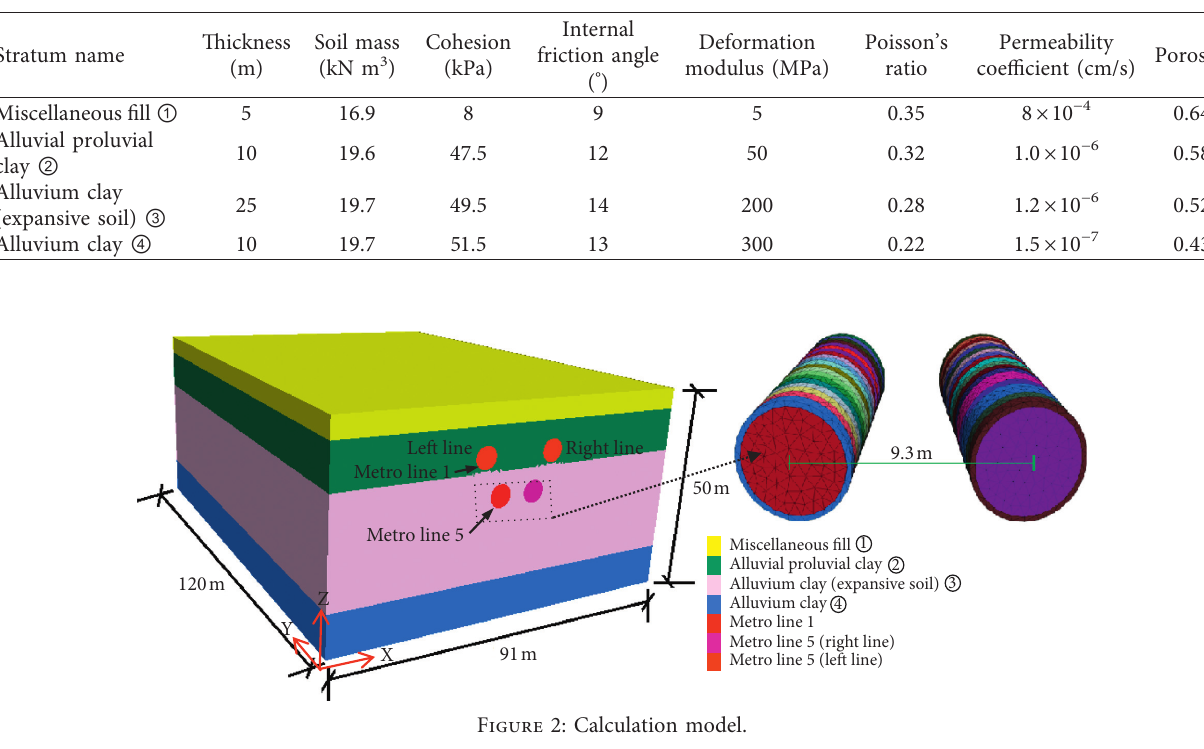
Table 1: Physical and mechanical parameters of